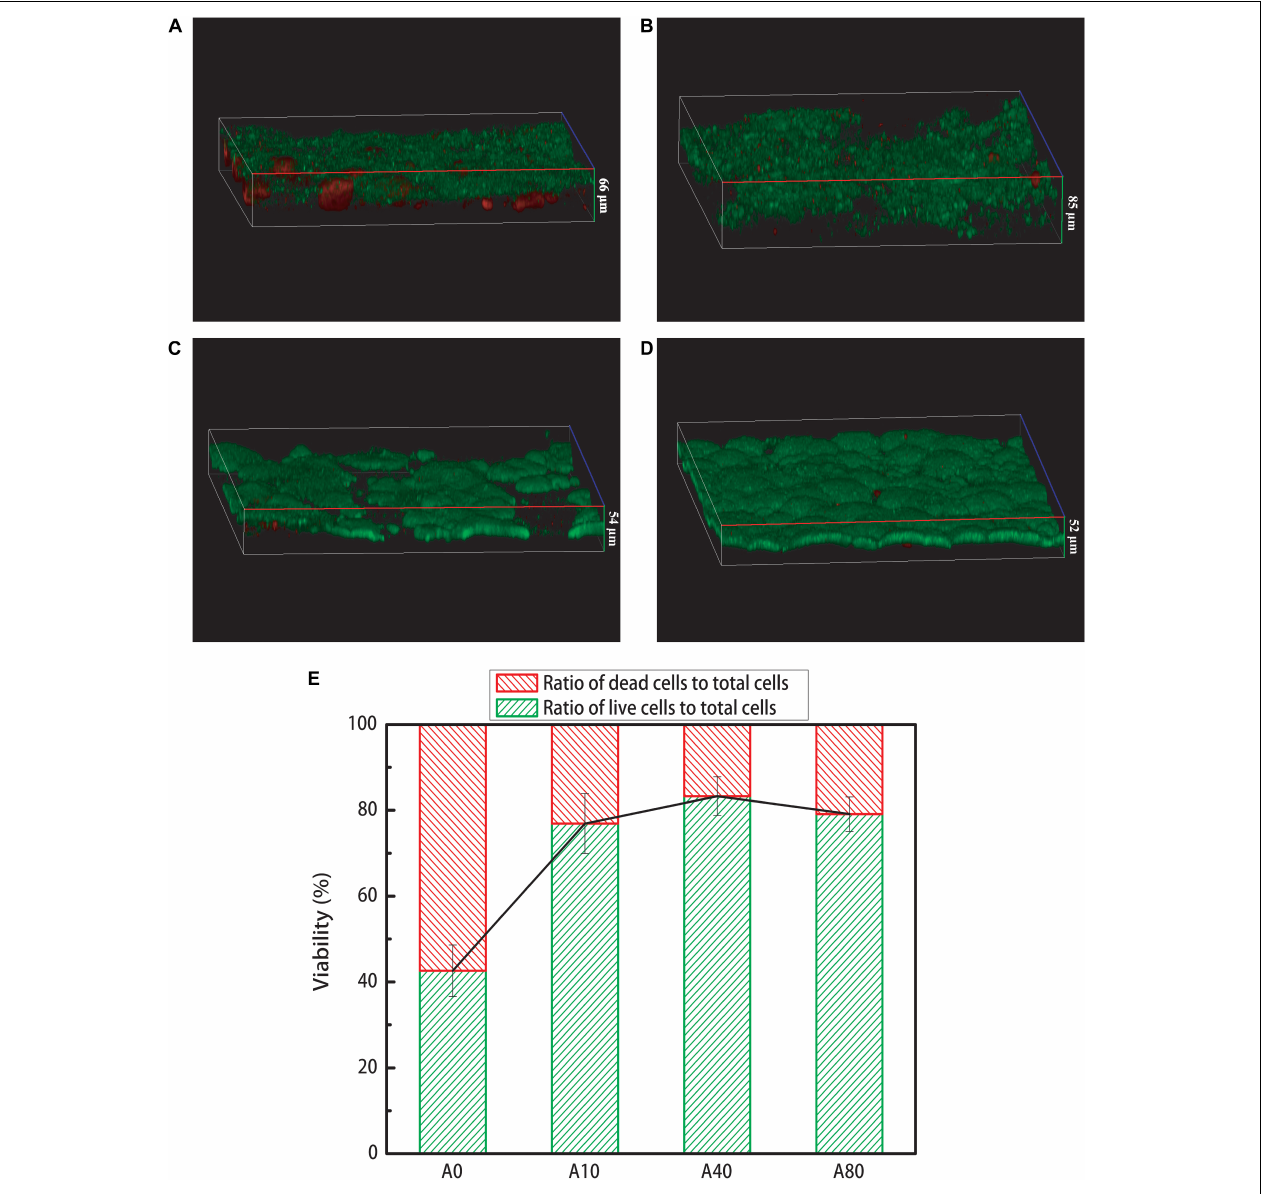
FIGURE 4 | 3D live/dead images of A0 (A) , A10 (B) , A40 (C) , and A80 (D) anode biofilms. (E) Ratio of live cells and dead cells to total cells based on pixel counting. The green color in (A–D) Represents live cells, whereas the red color represents dead cells. The numbers in (A–D) represent the thickness of anode